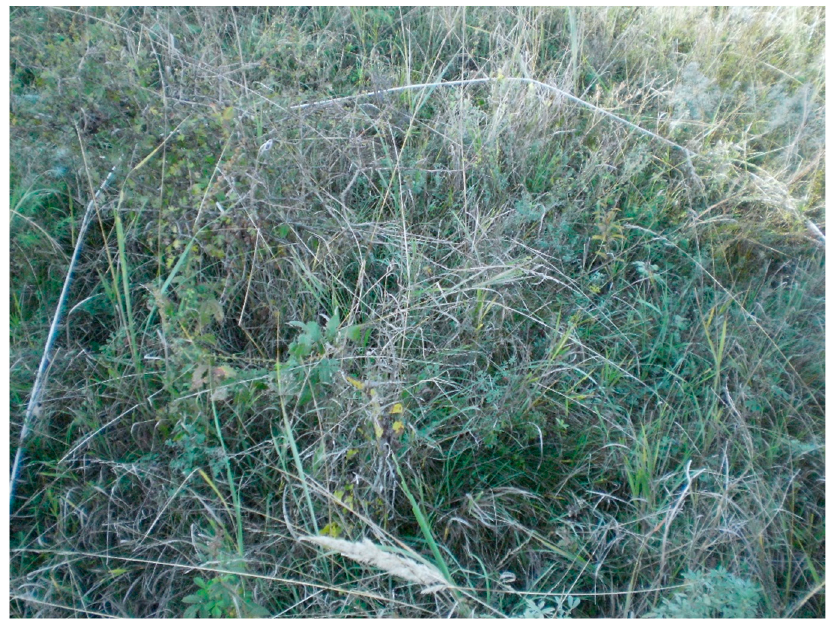
Figure 2. Control quadrat No. 7.